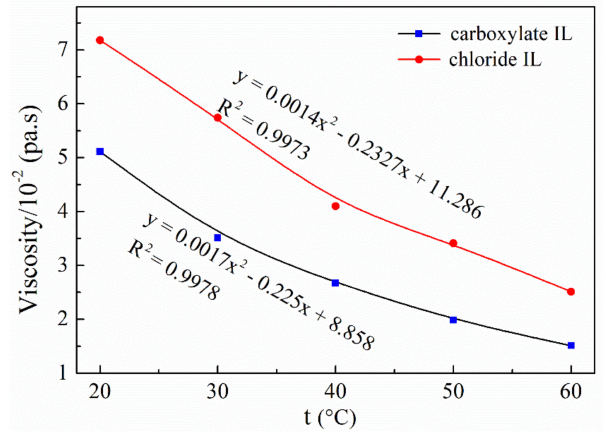
Figure 3. The viscosity of ILs at different temperatures.